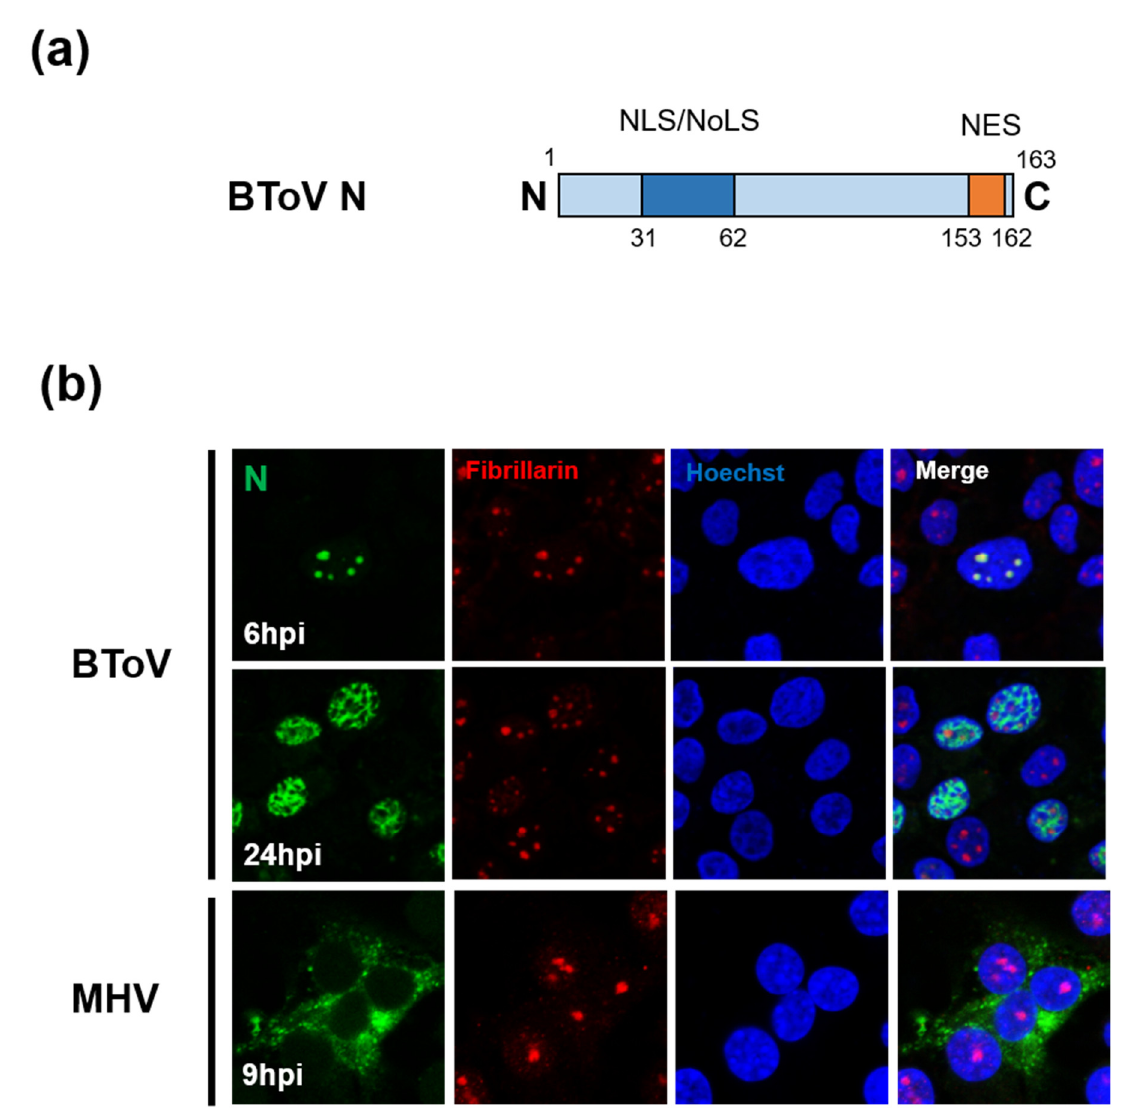
Figure 6. ( a ) Schematic diagrams of the N protein of ToV, with two nuclear/nucleolar localisation signals (NLS/NLoS) and nuclear export signals (NES). ( b ) Subcellular localisation of BToV or MHV (CoV) N proteins in infected cells. The cells were fixed and permeabilised at the indicated hours post-infection (hpi). N proteins and nucleolar marker fibrillarin were detected using mouse anti-N antiserum (green) and anti-fibrillarin rabbit mAb (red), respectively. The nucleus was stained with Hoechst solution (blue).